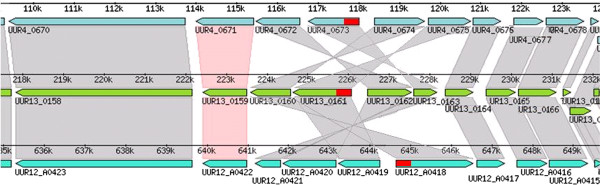
The MBA Locus in UUR4, UUR12, and UUR13. Genes in each genome are represented as directional blue or green boxes. Orthologous gene clusters (COGs) are represented by gray or pink bands spanning across the tree genomes. The COG with a pink band represents the first mba gene in the MBA locus. The locus includes the next 4 genes following the gene in the pink labeled COG (all tree genome have 5 mba genes each). The conserved domain of the mba is marked by a red box. Rearrangements of the genes are visible by following the twisting of the connecting bands.